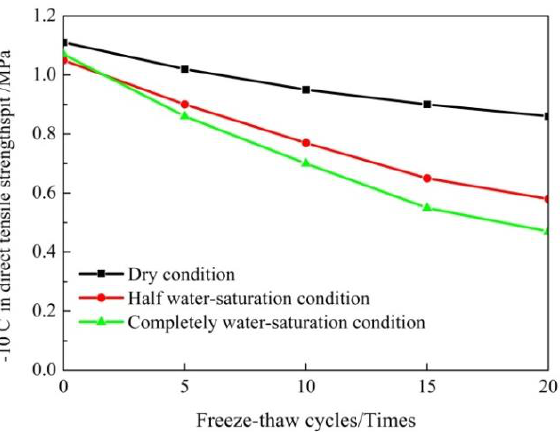
Figure 6. The indirect tensile strength test in low temperature under freeze–thaw cycles with different water saturation conditions.